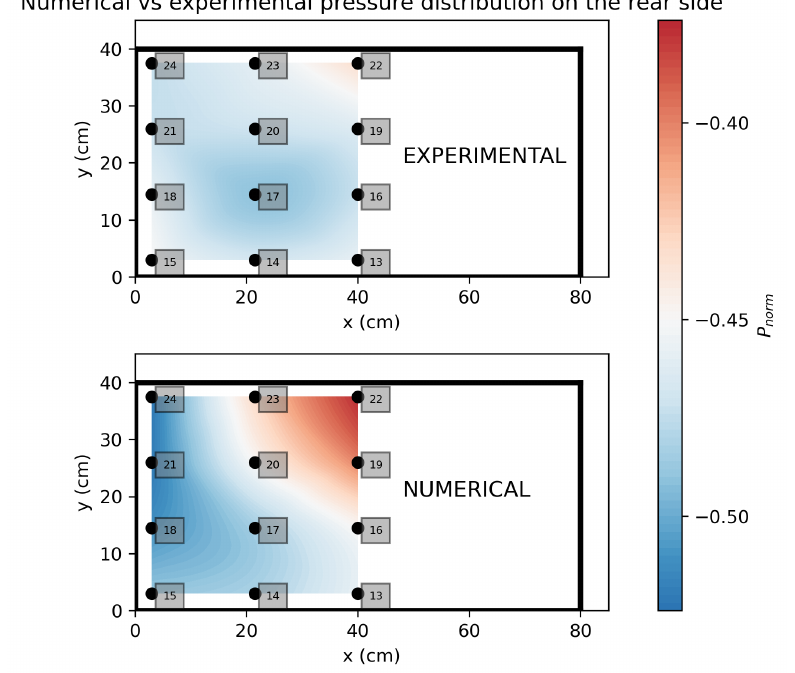
Figure 14. Numerical and experimental pressure distribution on the rear side of the panel: 10 m/s case.